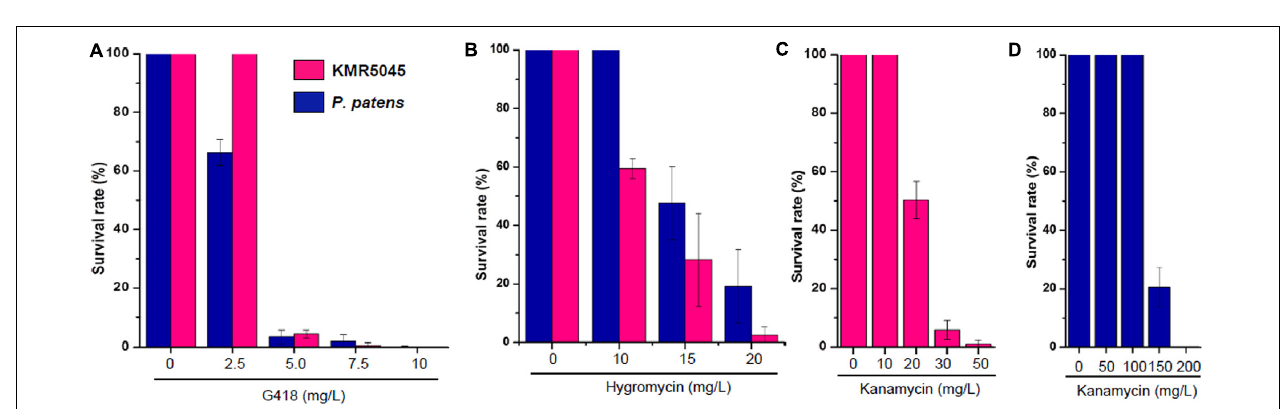
FIGURE 5 | Growth of KMR5045 and P. patens protonema cells under various antibiotic concentrations. Scale bars = 200 µ m